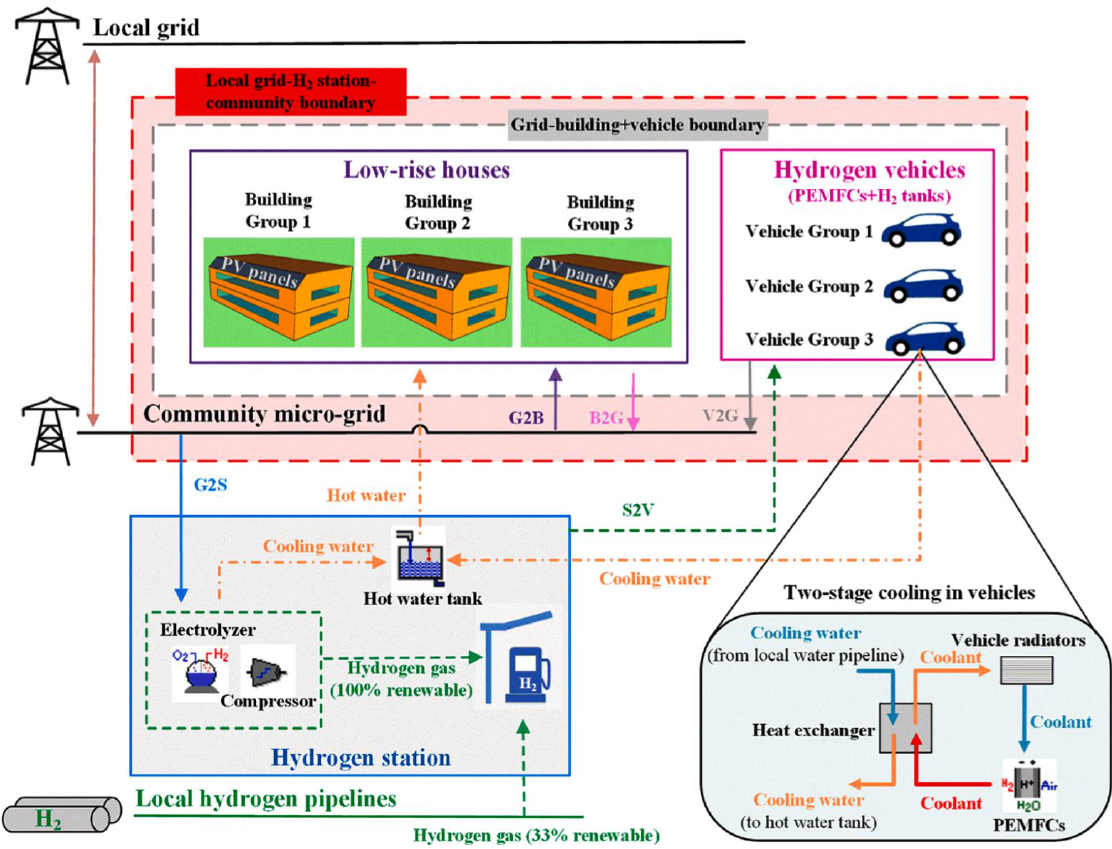
Figure 5. Schematic representation of a community microgrid with low-rise households, rooftop photovoltaics, fuel cell electric vehicles, and a hydrogen station. Reprinted with permission from Ref. [21]. 2021, Elsevier.